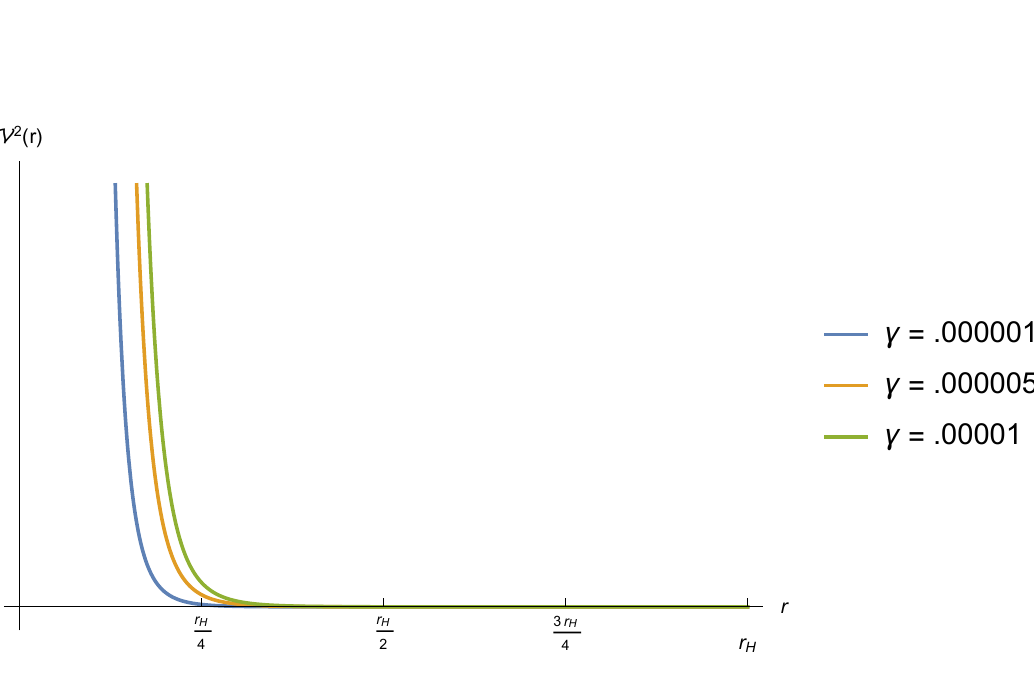
Figure 9. The square V 2 ( r ) of the volume functional for the (cid:13) -corrected AdS-Schwarzschild geometry in the Weyl 4 theory, plotted for several values of (cid:13) (labeled). Observe in particular that V 2 ( r ) diverges as r approaches the singularity, in contrast to the usual limiting behavior V ! 0.